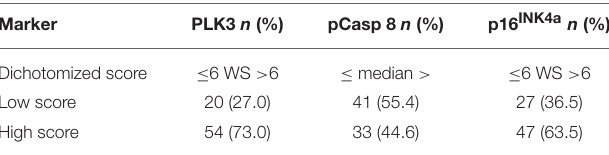
TABLE 1 | Results of PLK3, pT273 caspase 8, and p16 INK4a immunohistochemistry.